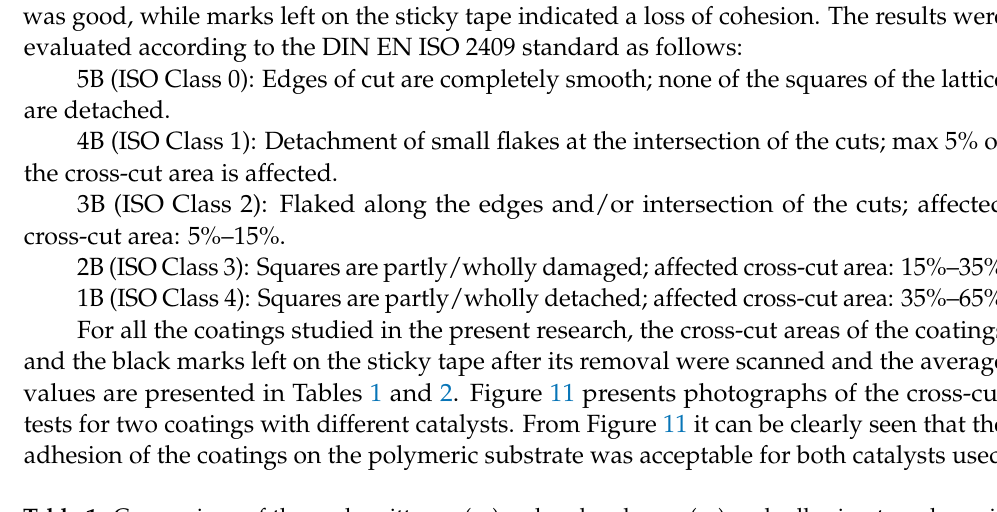
Figure 10. Three-step time test for TISS paints, prepared with fluoropolymer binder L200 and vari- ous concentrations of two catalysts: ( a ) Desmodur N75 and ( b ) Desmodur N3300, respectively: 1st